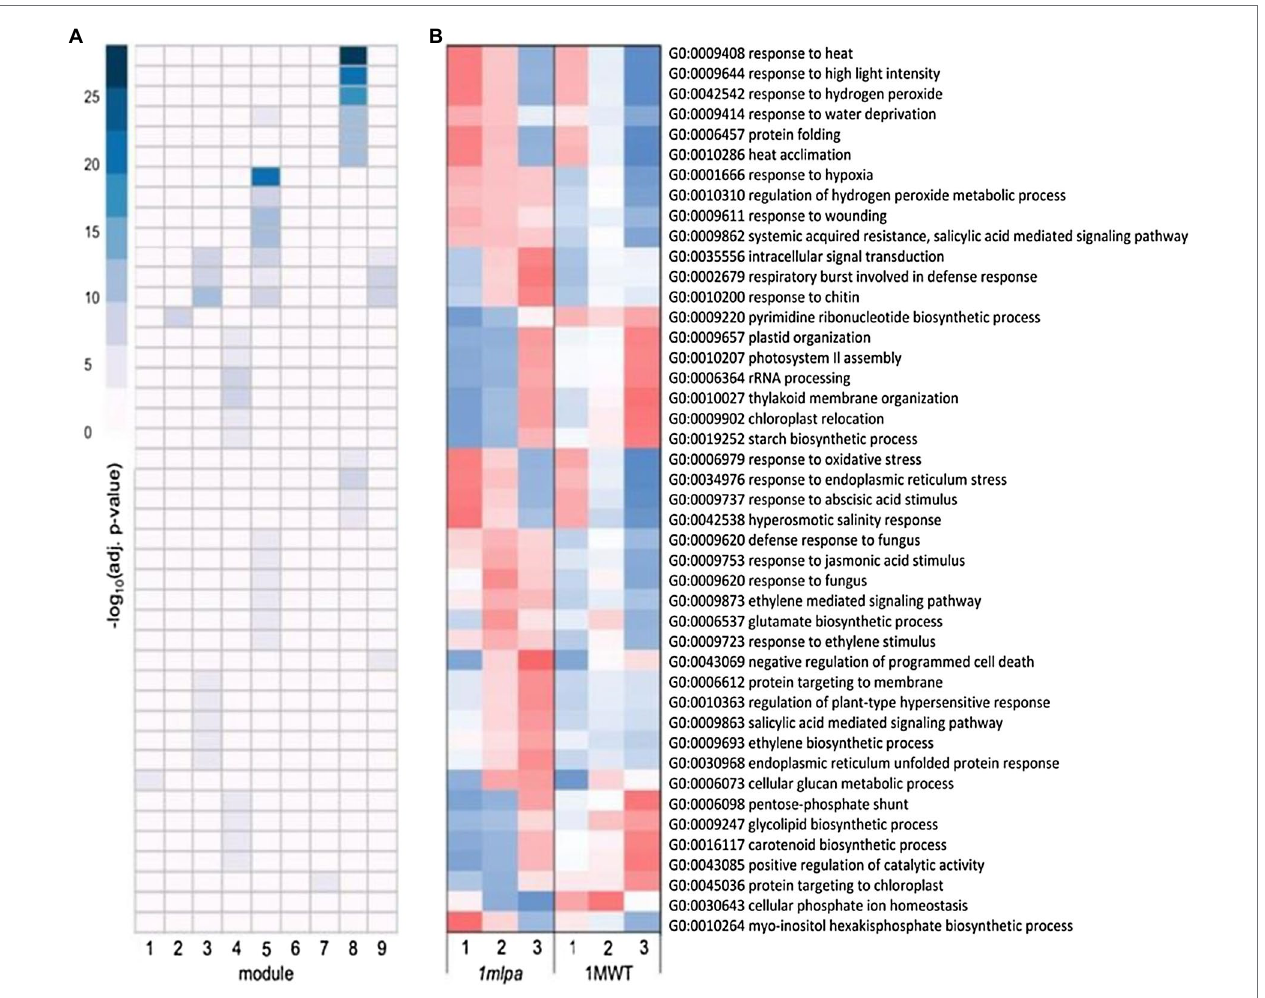
FIGURE 2 | Monophosphate synthase subset gene co-expression modules and significantly enriched biological processes. A module is defined as a group of genes sharing similar expression profiles over time and likely involved in the same biological processes. Rows represent hierarchical clustering of significantly enriched gene ontology (GO) categories. Significantly enriched GO categories were defined as those with a false discovery rate (FDR) < 0.05. (A) Heatmap of significantly enriched GO biological processes in each gene co-expression module. Columns represent modules. Color represents − log 10 adjusted value of p . (B) Average scaled expression of genes in significantly enriched biological processes. Columns represent germination stages of 1mlpa and 1MWT. Red color represents increased expression, and blue color represents decreased expression. Enrichment for all GO categories can be found in Supplementary Table S2